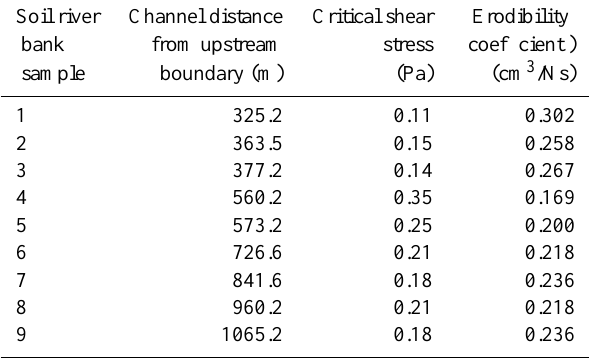
Table 1. Experimental results from river bank soil samples collected at different locations along the downstream part of the Koiliaris River (Lilli,